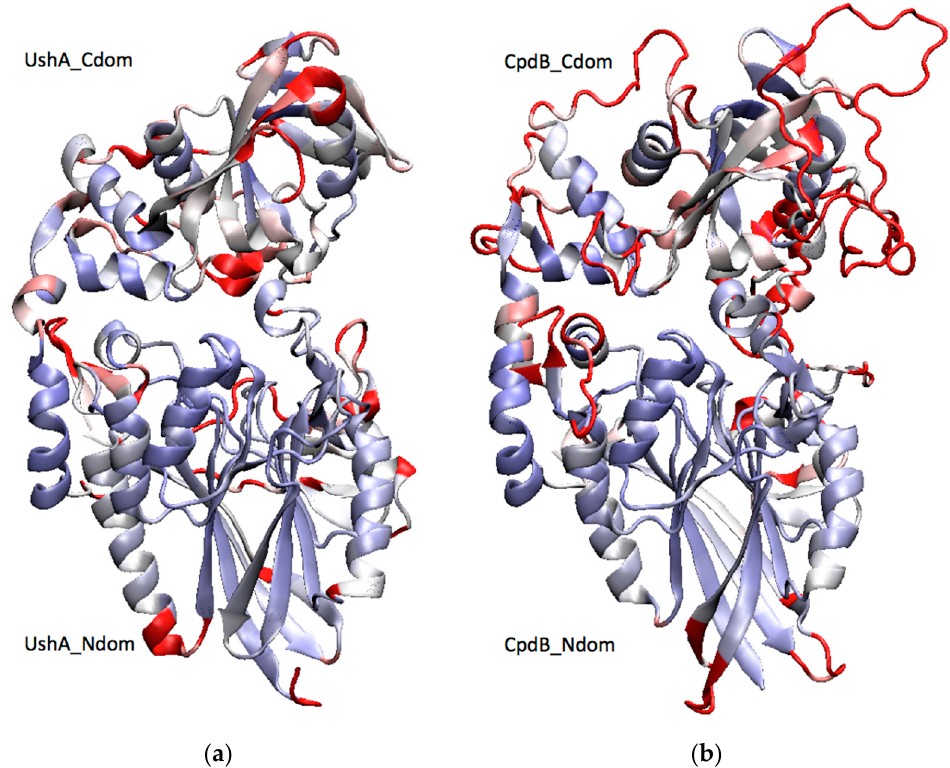
Figure 1. Two-domain structures of ( a ) UshA and ( b ) CpdB. A structural alignment of the crystal structure of a closed conformer of UshA (PDB: 1HPU, chain C) [30] with a homology model of CpdB [27] was generated with the VMD MultiSeq plugin [31], and it was used to color both proteins by structure conservation (blue, conserved; red, not conserved). UshA_Ndom, UshA_Cdom, CpdB_Ndom, and CpdB_Cdom (N-terminal and C-terminal domains of UshA or CpdB).